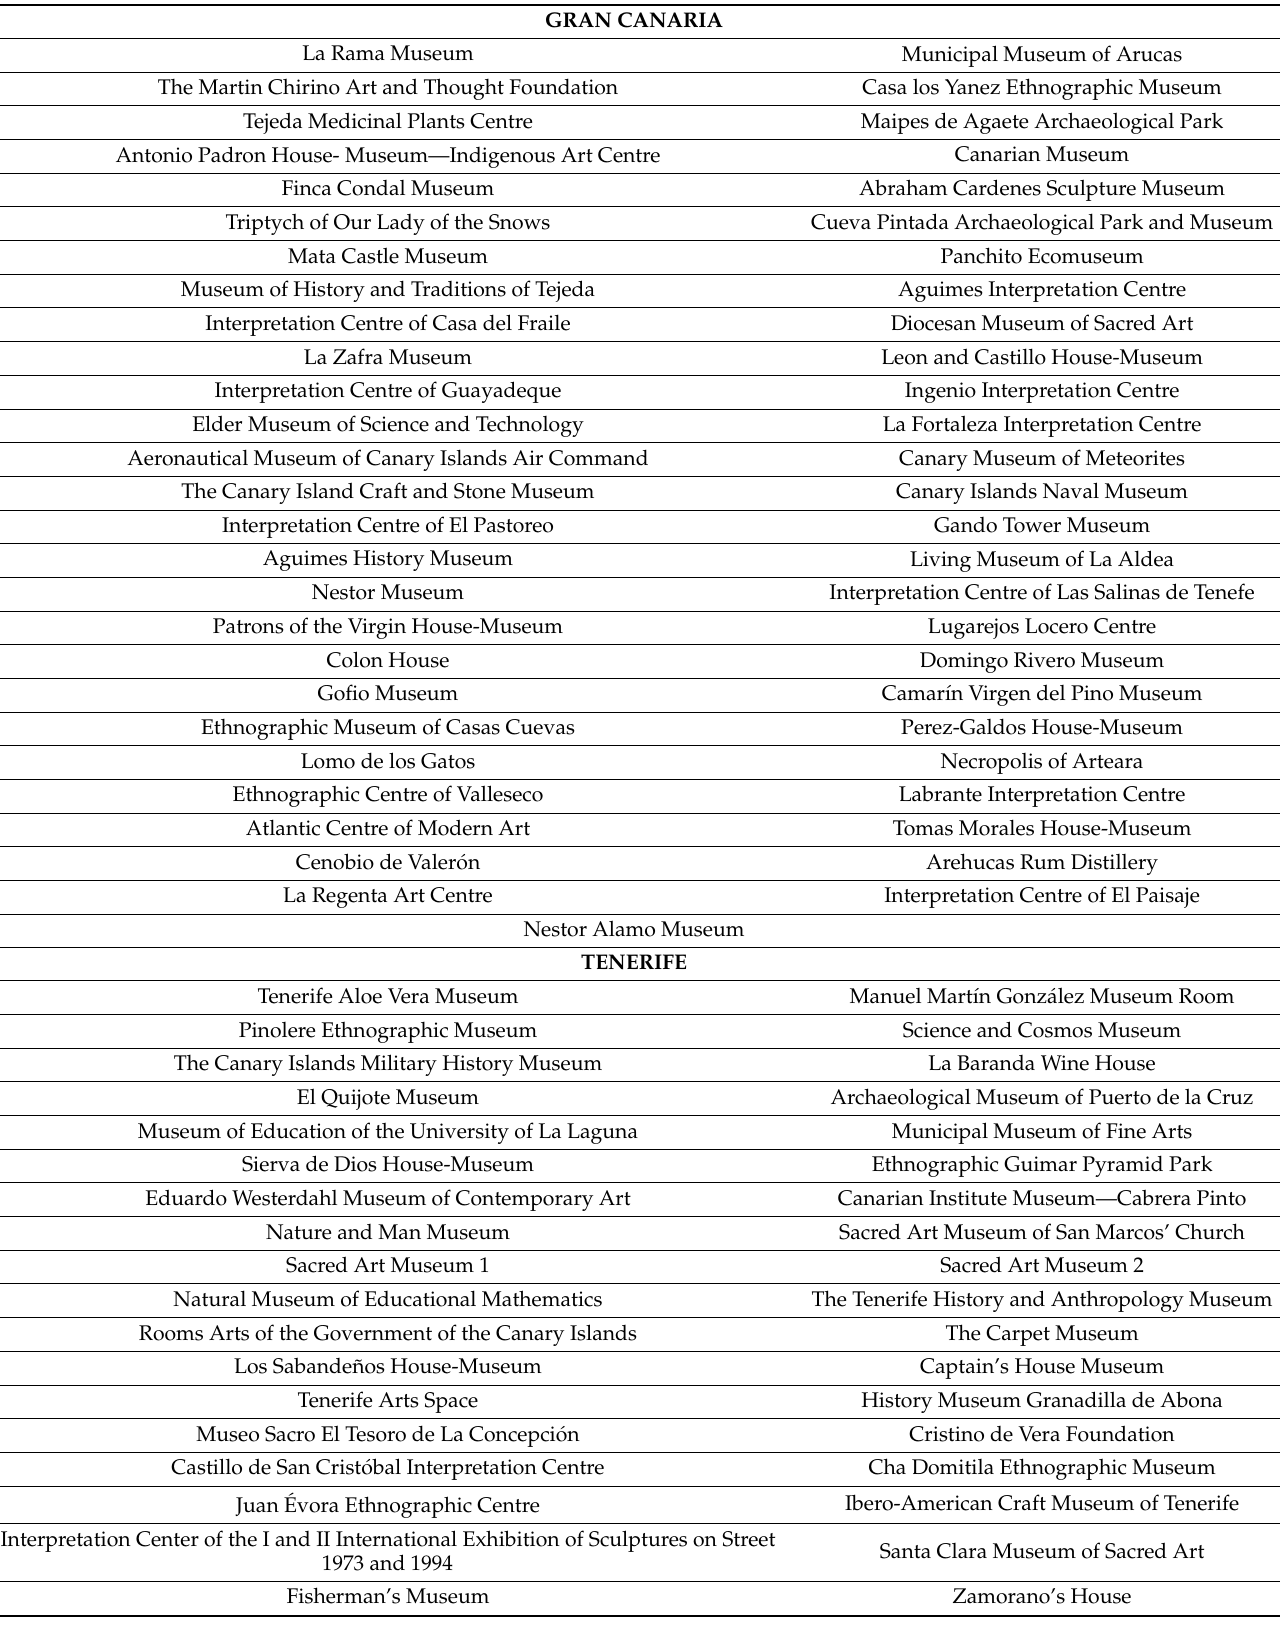
Table 2. Gran Canaria and Tenerife’s museums. GRAN